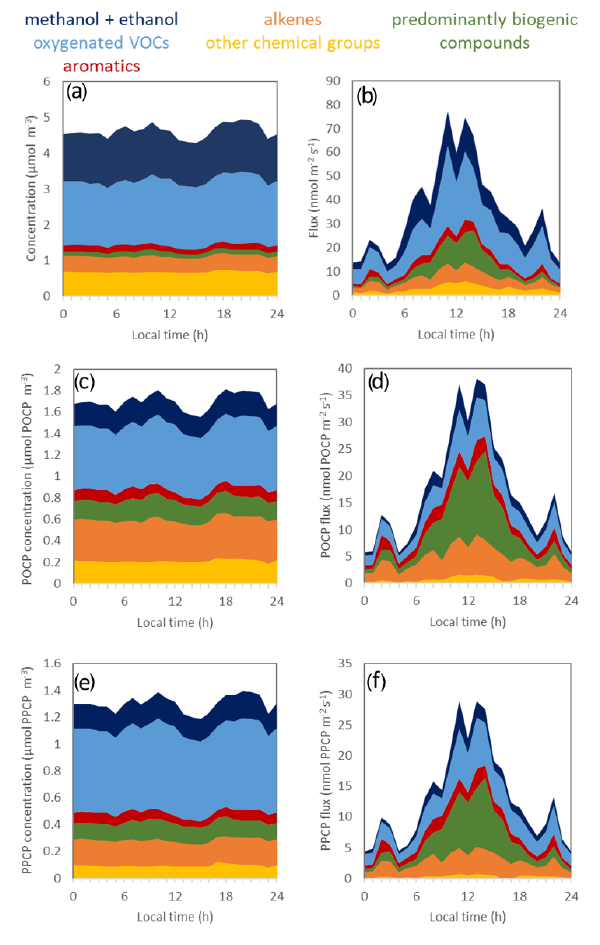
Figure 7. Total observed VOC concentration (a) and flux (b) mea- sured during the summer field campaign, scaled using photochem- ical ozone creation potentials (POCPs) (c, d) and photochemical PAN creation potentials (PPCPs) (e, f) .